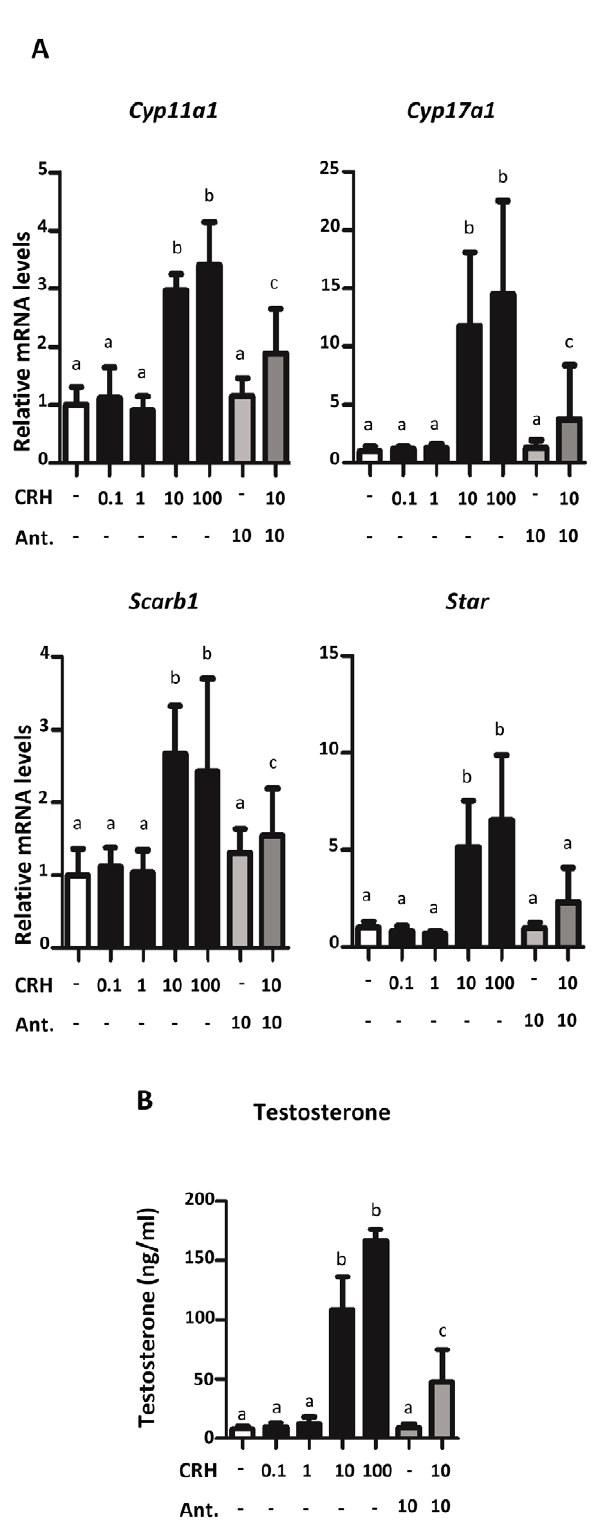
Figure 6. Effects of CRH on steroidogenic gene expression in GD15 mouse testis. A) Steroidogenic mRNA expression increased after treatment with CRH and/or antagonist in GD15 mouse testis. Eight to twenty-one samples/group were exposed for 24 hours in vitro to varying concentrations of CRH and/or 10 m M of antagonist. mRNA levels were determined by Taqman-based qRT-PCR. Mean 6 SD shown for all data. a indicates no significant change between treated samples